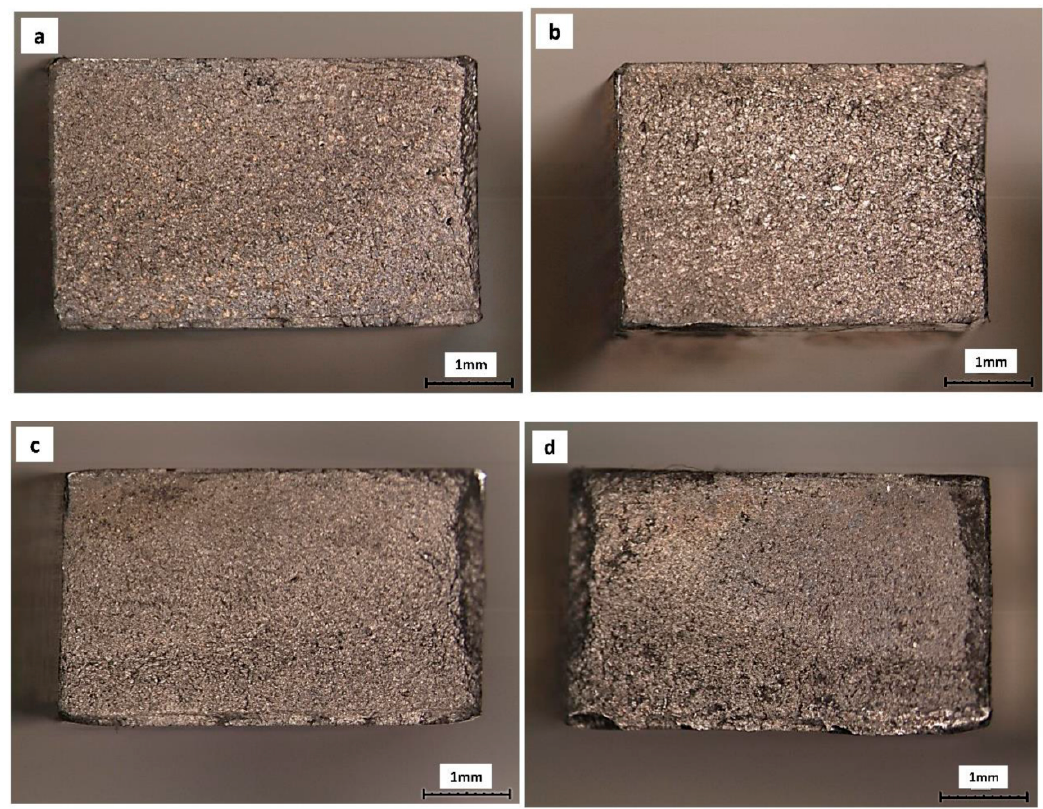
Figure 9. The typical fracture surfaces obtained after low cycle fatigue in air: ( a ) Mg-5Zn, ( b ) Mg-5Zn- Figure9. Thetypicalfracturesurfacesobtainedafterlowcyclefatigueinair: ( a )Mg-5Zn,( b )Mg-5Zn-1Nd, 1Nd, ( c ) Mg-5Zn-2Nd and ( d ) Mg-5Zn-3Nd. ( c ) Mg-5Zn-2Nd and ( d )